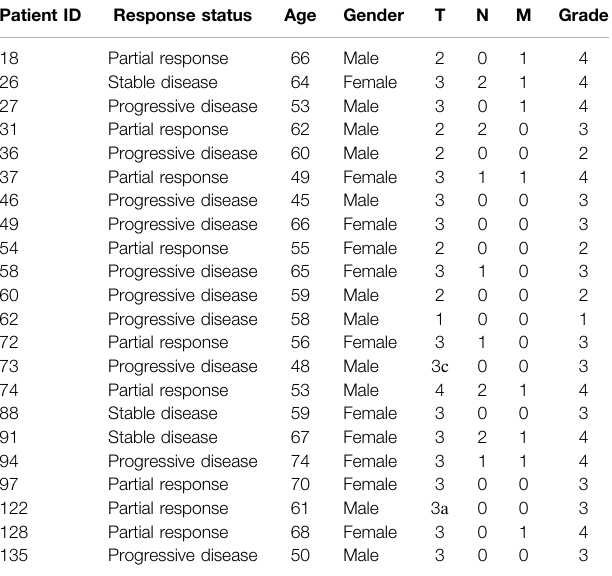
TABLE 1 | Clinical information for RCC patients pro fi led using Illumina HumanHT- 12 WG-DASL V4.0 R2 gene expression arrays Patient ID